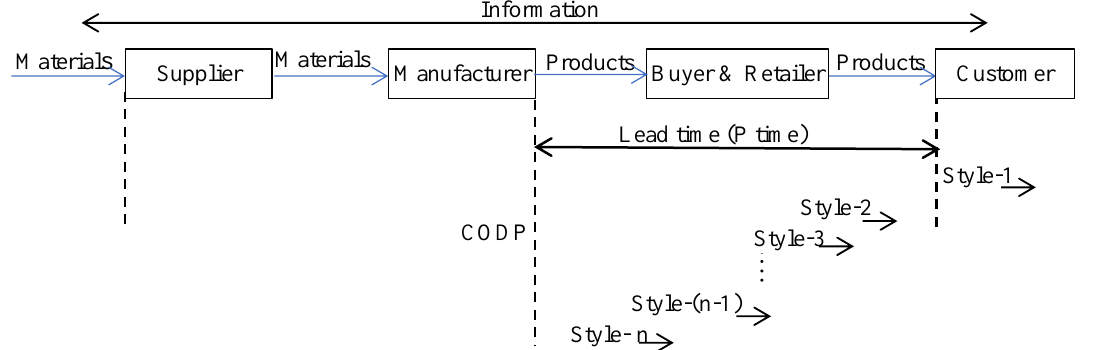
Figure 8. Concurrent and parallel production of various